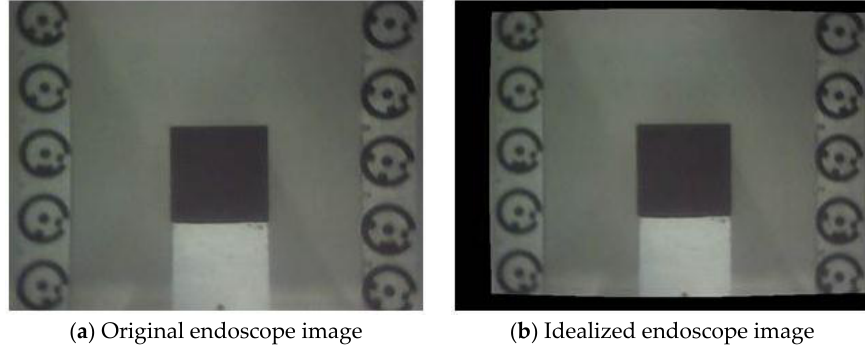
Figure 7. Black metal cube image using the endoscope camera in the plastic water tank.